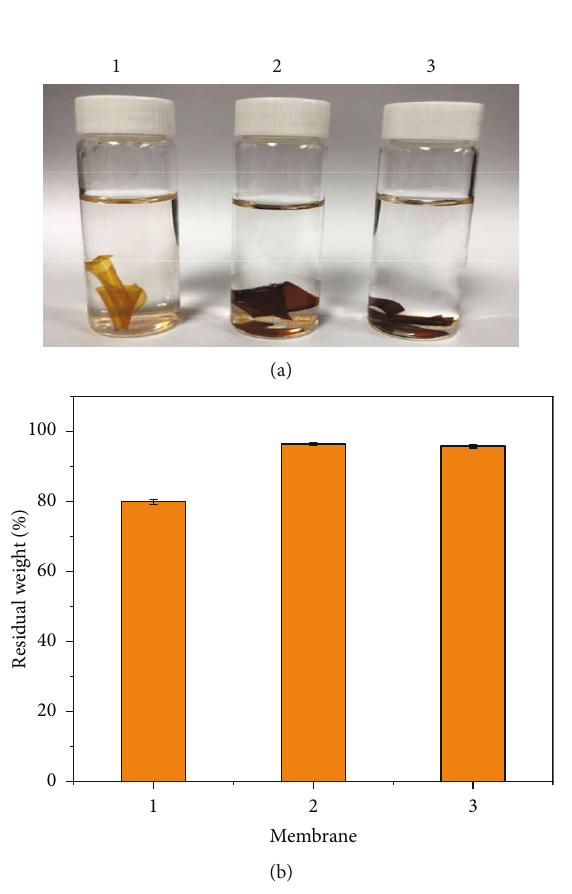
Figure 7: (a) Photographs and (b) residual weight of the membranes after the Fenton test: (1) PBI, (2) PAEK- cr -PBI, and (3) PAEK- cr -PBI@PBI.